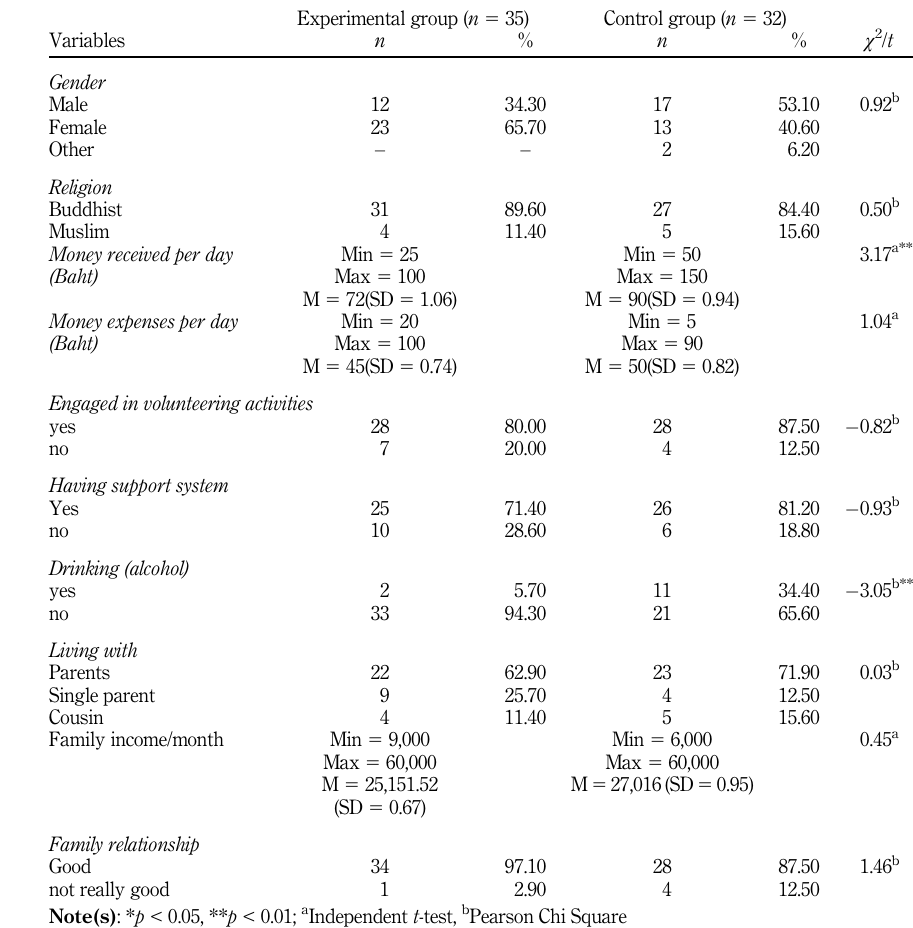
Table 1. Comparison of participants ’ demographic characteristics at baseline between groups ( n 5